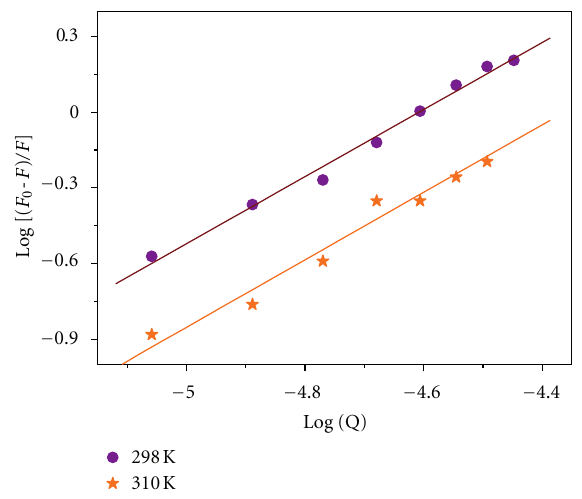
F 5: Logarithmic plot of the �uorescence quenching of BSA with various amounts of Evo at 298K (•) and 310K (